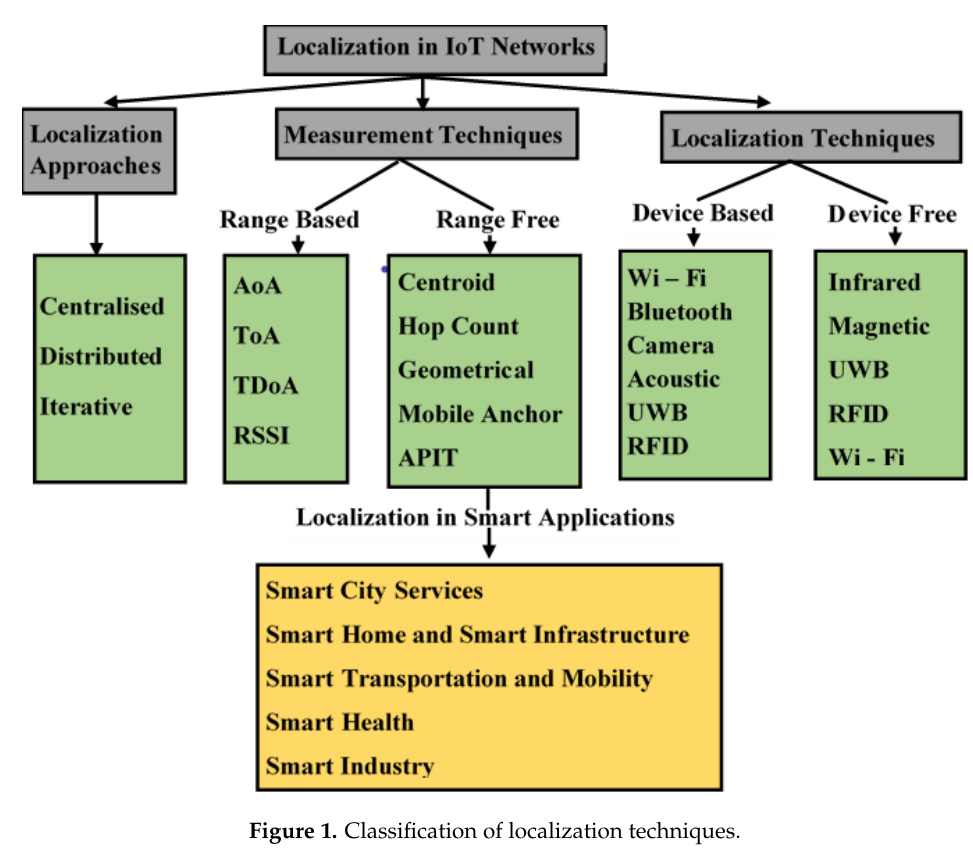
Figure 1. Classification of localization techniques.